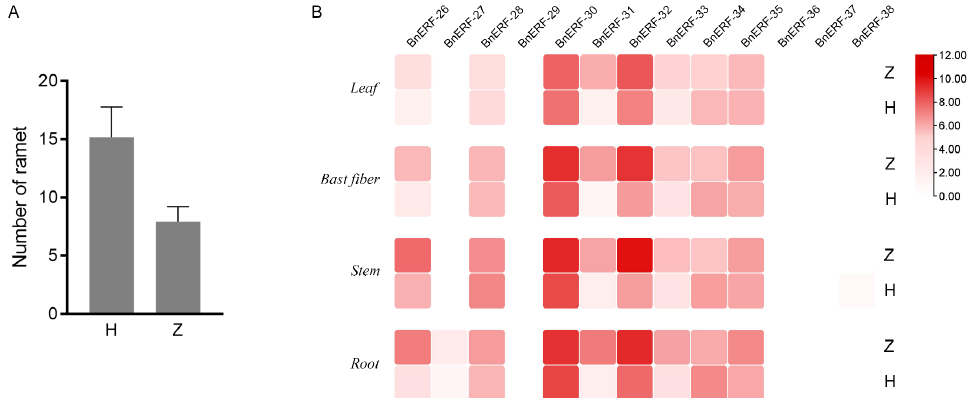
Figure 9. ( A ) Differences in the number of ramets of two ramie varieties. H denotes the ramie variety “He jiang qing ma” with a high number of ramet. Z denotes the ramie variety “Zhongzhu No.1” with a low number of ramet. ( B ) Relative expression profiles of group VIII members of BnAP2/ERF TFs in different tissues of the two ramie varieties.